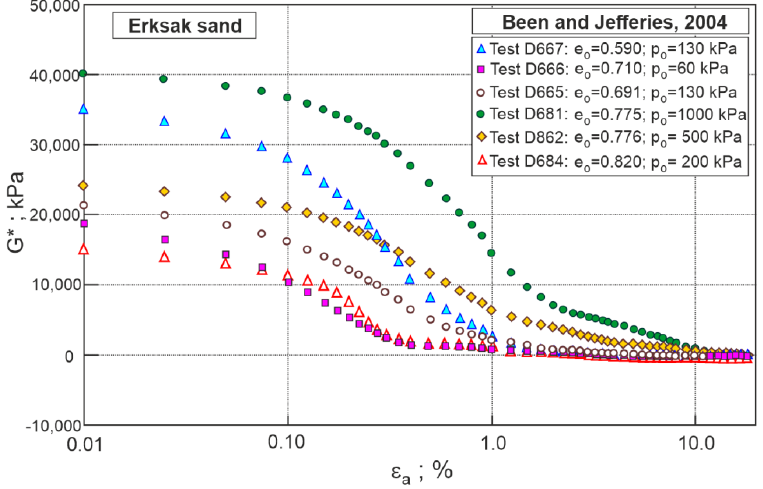
Figure 3. Change of G* during shear.